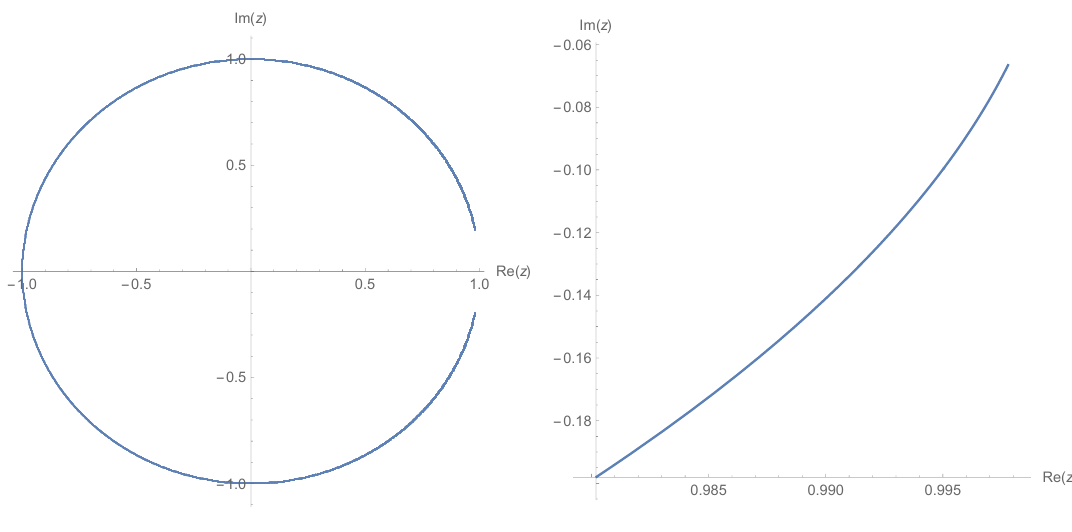
Figure 9 . We plot z and ¯ z as we increase t from 0 to 10 with y 0 = 5 , (cid:15) = 0 . 5 z moves on the unit circle from above the real axis to below the z axis counter-clockwise, while ¯ z always stays below the real axis close to